Question: Provide a publication-style caption for this figure.
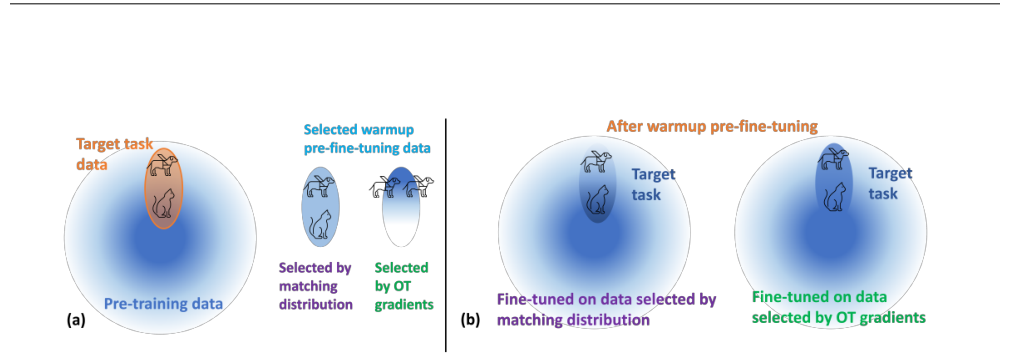
Answer: Consider an LLM pre-trained on a large corpus of 99% cat examples and 1% dog examples. The target task consists of 50% cat examples and 50% dog examples. The model’s relative lack of knowledge of dogs will be its performance bottleneck on the target task. Before deploying the LLM on the target task, we select samples from the pool of available data to perform lightweight warmup pre-fine-tuning to better prepare the model for the target task knowledge. Selecting data by matching distribution to the target task will end up selecting 50% cat and 50% dog examples, where only the 50% dog examples will help. In low data regimes where the fine-tuning data is considerably small, this further loss of data efficiency prevents the model from achieving the best possible performance improvements. Our gradient-based selection will select 100% dog examples, which best help the model to make up for the knowledge it lacks. In this case, our approach is able to double the data efficiency in fi